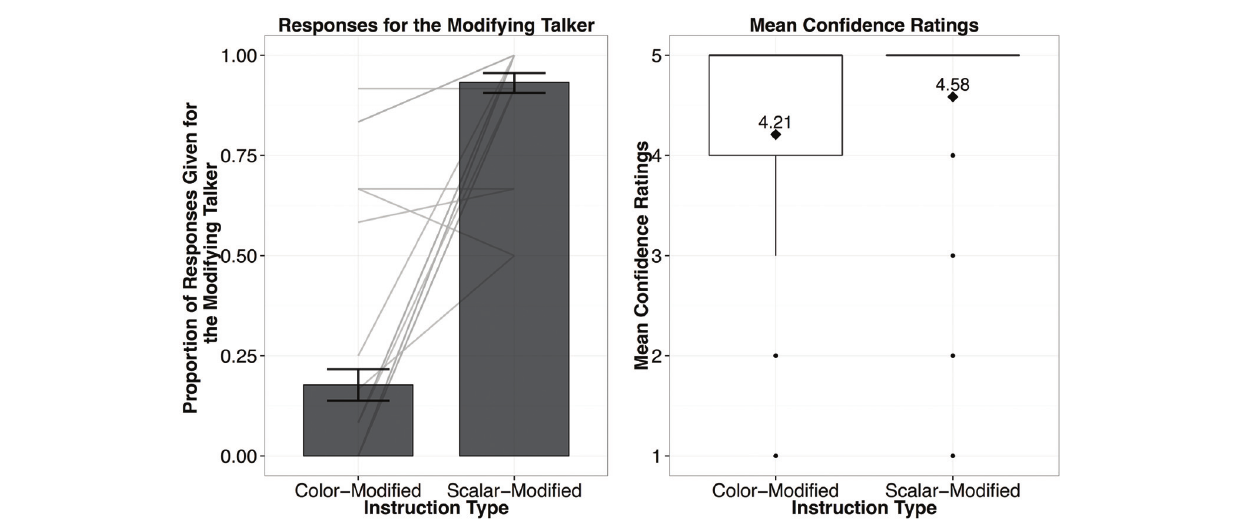
FIGURE 5 | Results from Experiment 2B, showing the proportion of responses given for the modifying talker by Instruction Type (left; light gray bars reflect individual participant means), and the confidence ratings for responses by Instruction Type (right; diamond dots reflect the mean rating out of